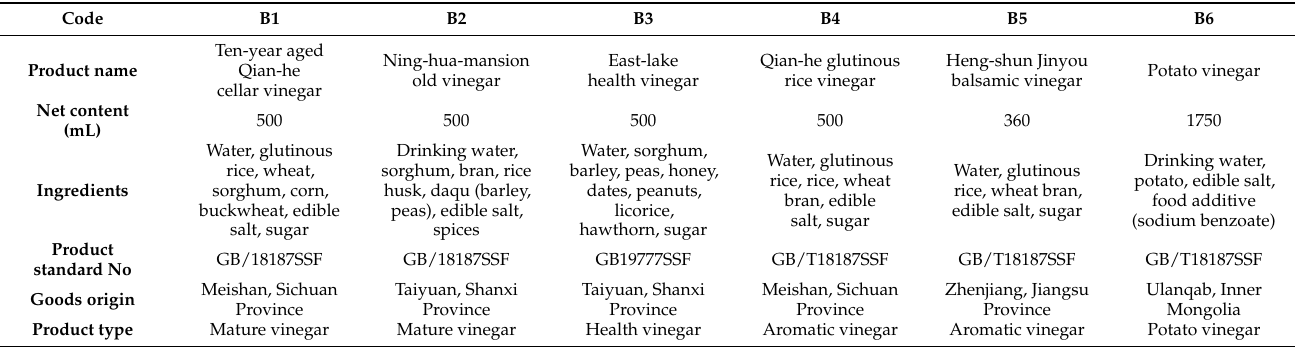
Table 1. Detailed information on six kinds of Chinese